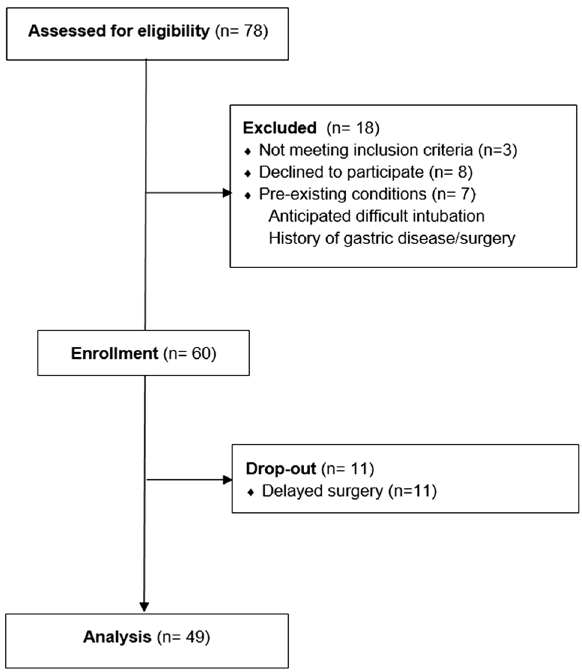
Figure 4. The Consolidated Standards of Reporting Trials (CONSORT) diagram of